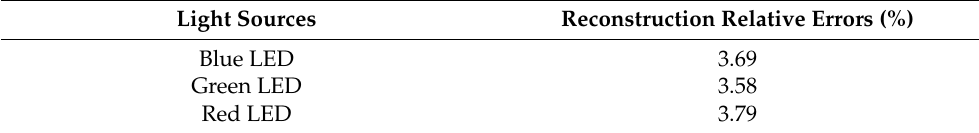
Table 1. Reconstruction relative errors of LED light